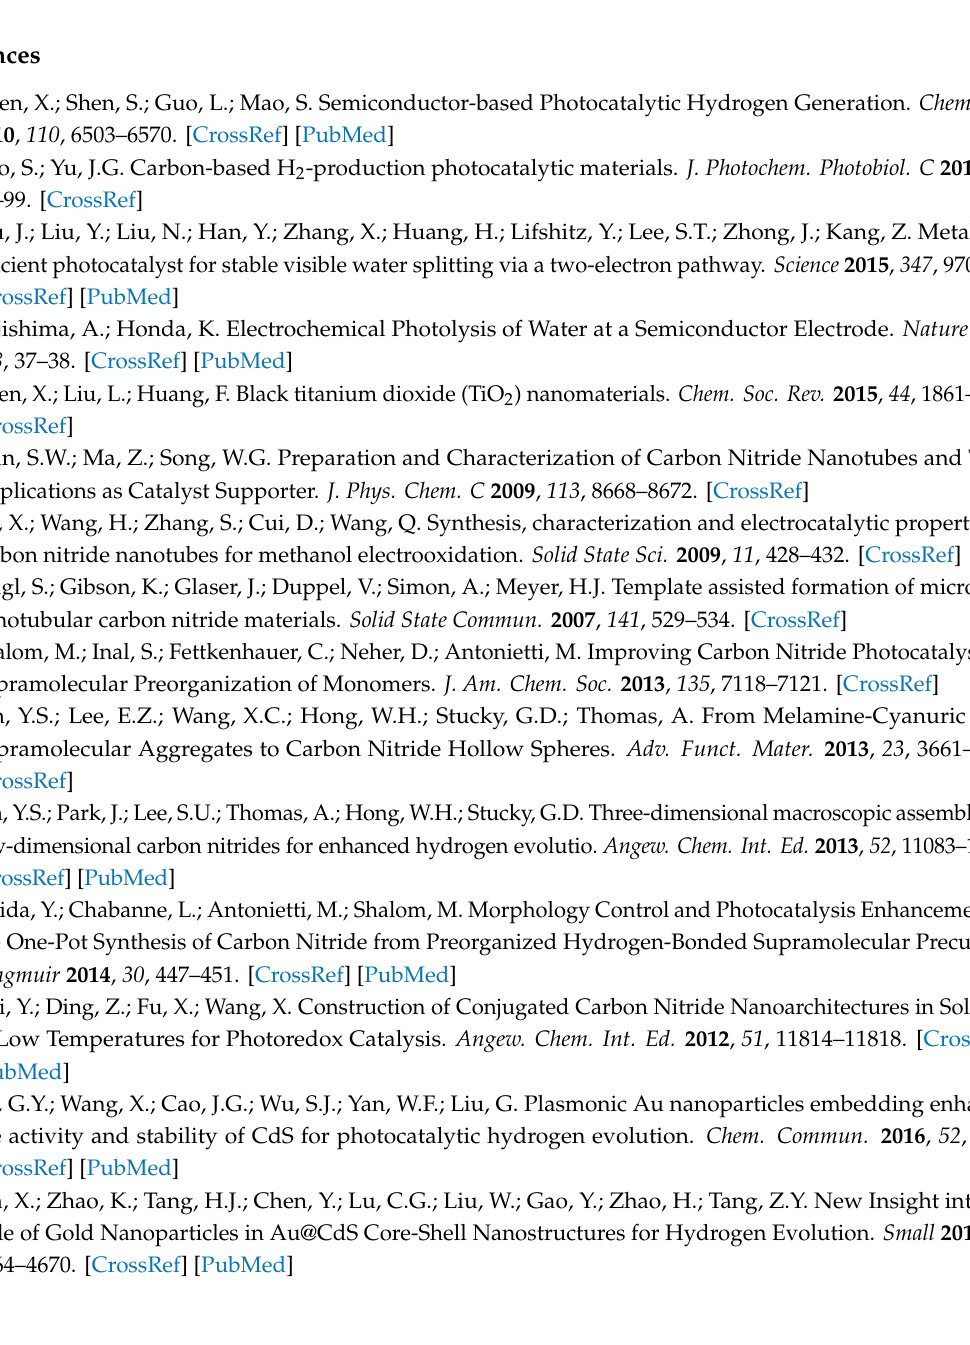
Figure S1: The picture of CoO x -NDCNTs sample; Table S1: The elemental analysis of di ff erent samples; Table S2: EQE value calculated at di ff erent